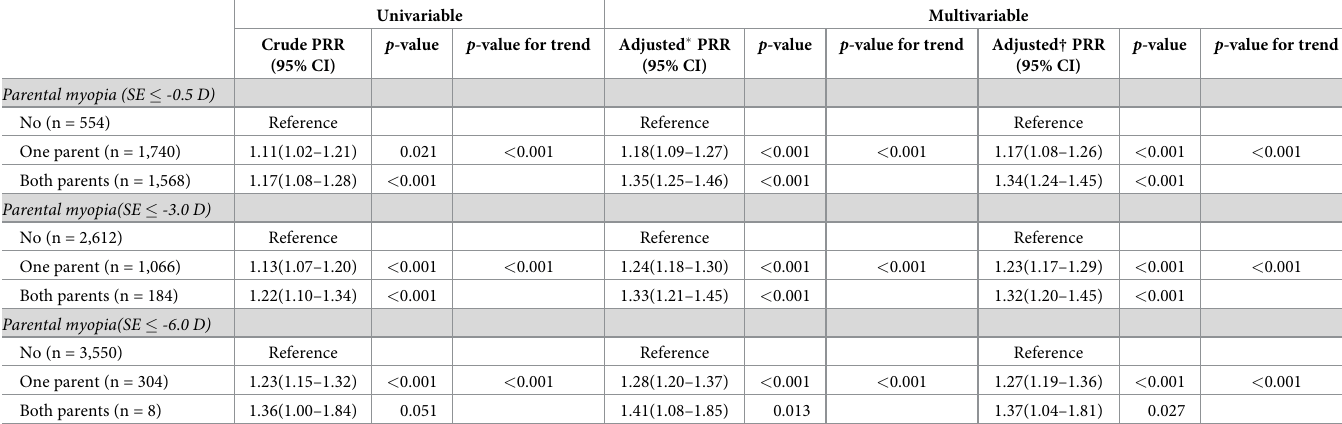
Table), the corresponding estimates were 1.17 (1.08–1.26), and 1.34 (1.24–1.45), respectively ( P < 0.001). These findings were consistent after adjustment for potential confounders but slightly weakened the association between parental and pediatric myopia, suggesting the influ- ence of common environmental effects on pediatric myopia within a family. As parental myo- pia increased from mild (SE � -0.5 D) to moderate (SE � -3.0 D) and severe (SE � -6.0 D), the crude and adjusted PRRs also increased, and a significant association between pediatric and parental myopia was also shown (Table 2). Table 2. Prevalence rate ratios and 95% confidence intervals for pediatric myopia (SE � -0.5 D) according to the presence of parental myopia. Univariable